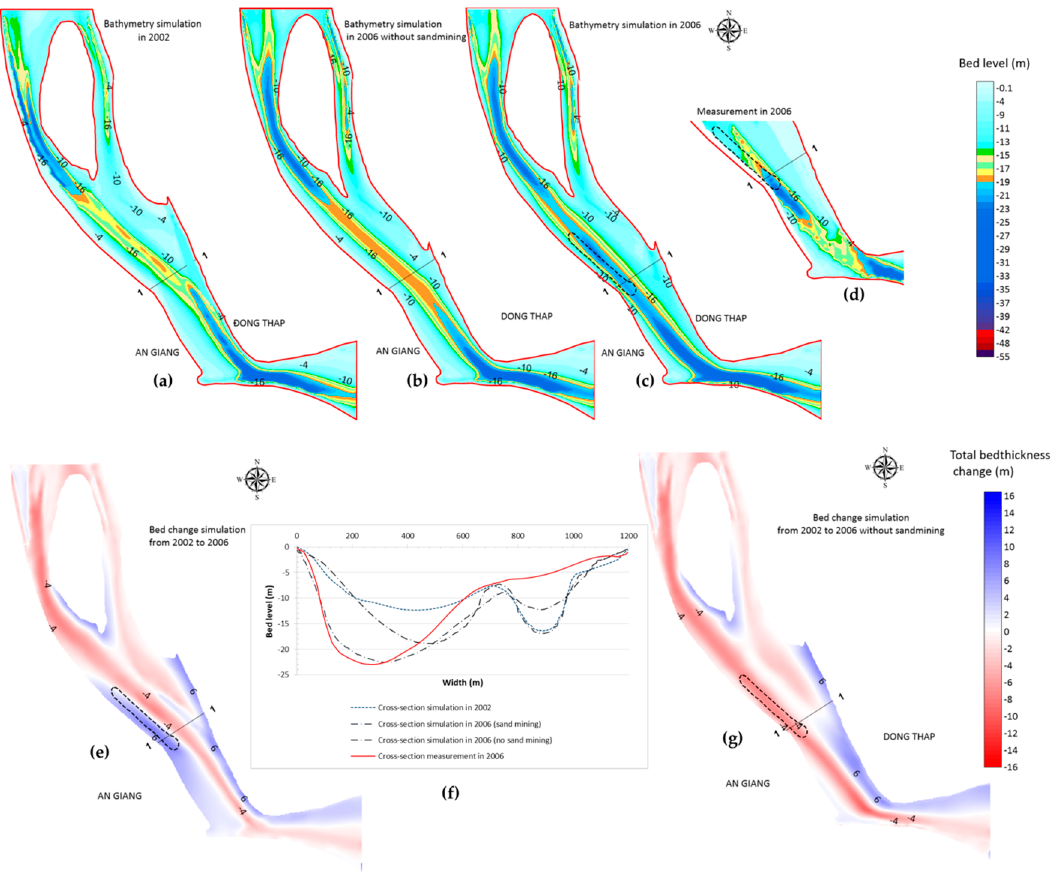
Figure 14. Simulation of the bed changes over 4 years from 2002 to 2006: ( a , c ) the results of simulations for 2002 and 2006, respectively; ( b ) the case with no sand simulation for 2006; ( d ) riverbed measurements in 2006; ( e , g ) bed change simulations during the period with sand mining and no sand mining, respectively; ( f ) comparison graphs of simulations and measurements at cross-section 1.1.